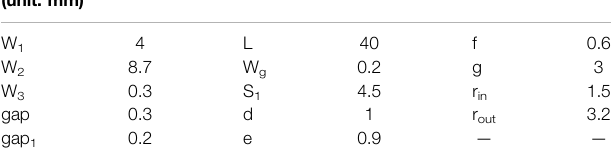
Frontiers in Physics |